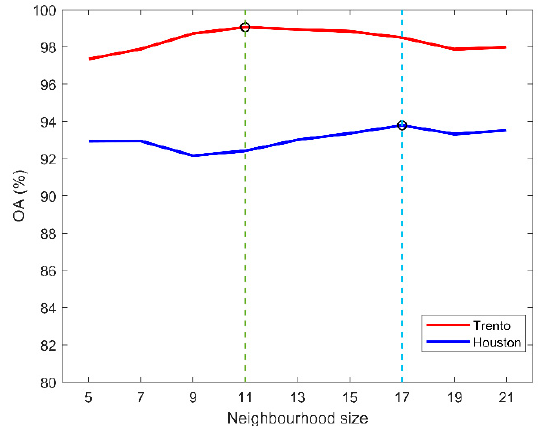
Figure 10. Effect of different neighborhood sizes on OA.